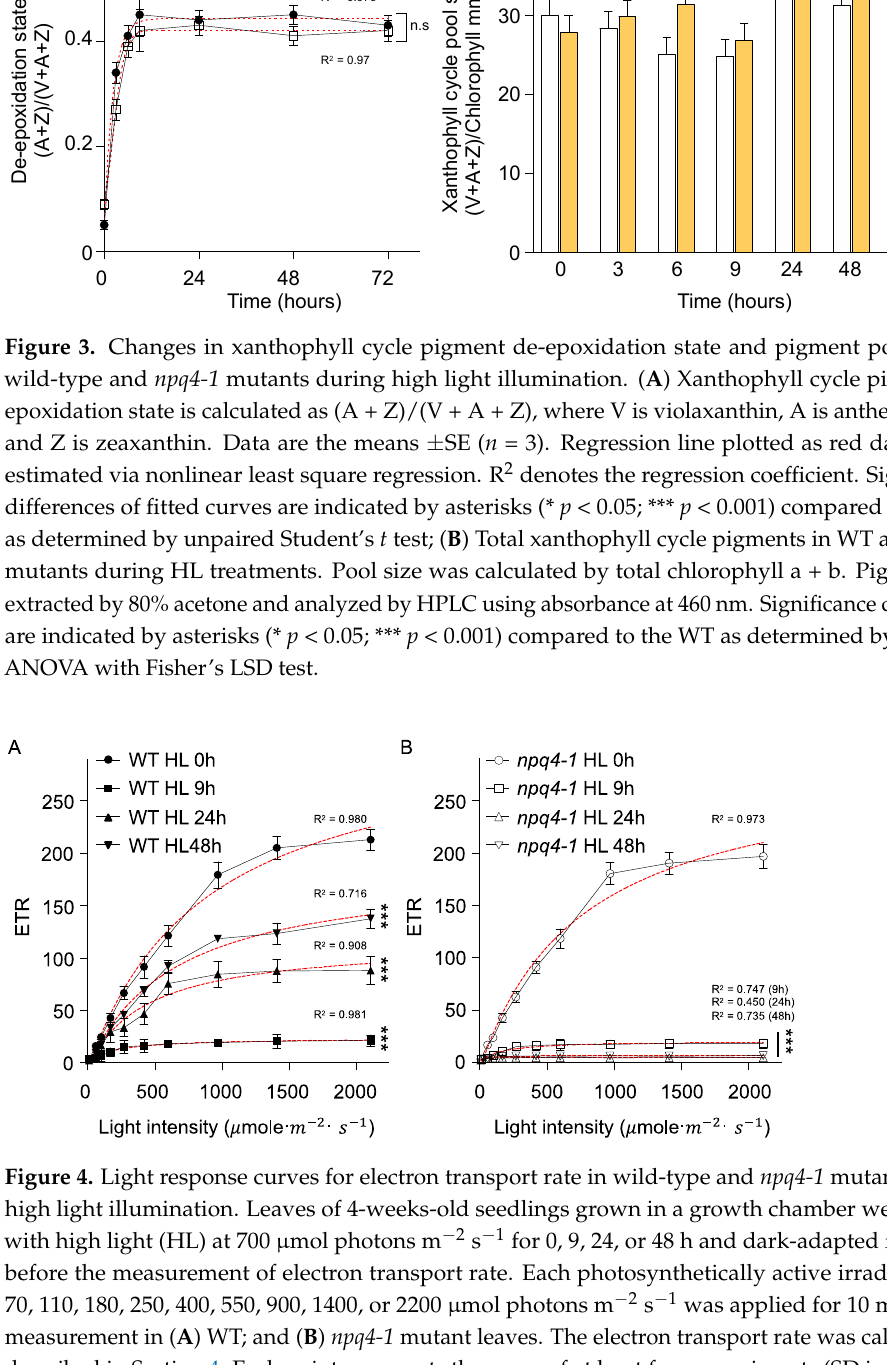
4 of 17 Figure 2. Light response curves for non-photochemical quenching in wild-type and npq4-1 mutants during high light illumination. Leaves of 4-weeks-old seedlings grown in a growth chamber were treated with high light (HL) at 700 μ mol photons m − 2 s − 1 for 0, 9, 24, or 48 h and dark-adapted for 10 min before the measurement of non-photochemical quenching (NPQ). Each photosynthetically ac- tive irradiance of 0, 70, 110, 180, 250, 400, 550, 900, 1400, or 2200 μ mol photons m − 2 s − 1 was applied for 10 min for the measurement in ( A ) WT; and ( B ) npq4-1 mutant leaves. NPQ was calculated as described in Section 4. Each point represents the mean of at least four experiments (SD indicated by the bar). Regression line plotted as red dashed line estimated via nonlinear least square regression. R 2 denotes the regression coefficient. Significance differences of fitted curves are indicated by aster- isks (* p < 0.05; *** p < 0.001) compared to the 0 h as determined by one-way ANOVA with Fisher’s LSD test. The major component of NPQ, energy-dependent quenching (qE) includes the accu- mulation of the xanthophyll cycle pigment zeaxanthin associated with the development of the pH gradient across the thylakoid membrane and the PsbS protein [7,25]. We com- pared the rise in kinetics of de-epoxidation state of the xanthophyll cycle pigments in WT